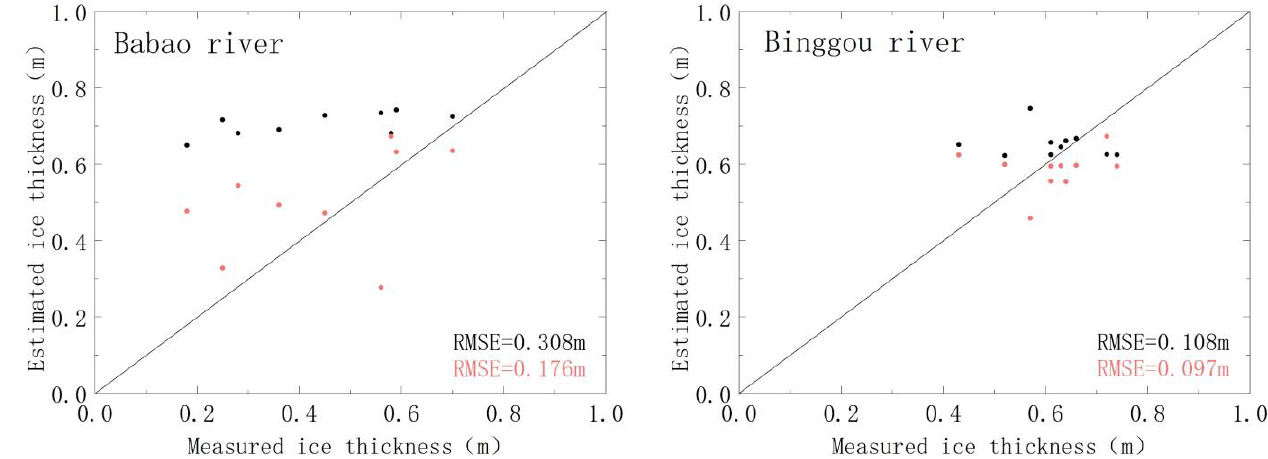
Figure 16. Comparison between predicted and measured thicknesses (black dots represent the inversion results of the Canadian formula, while orange dots are the inversion formula results from this paper).